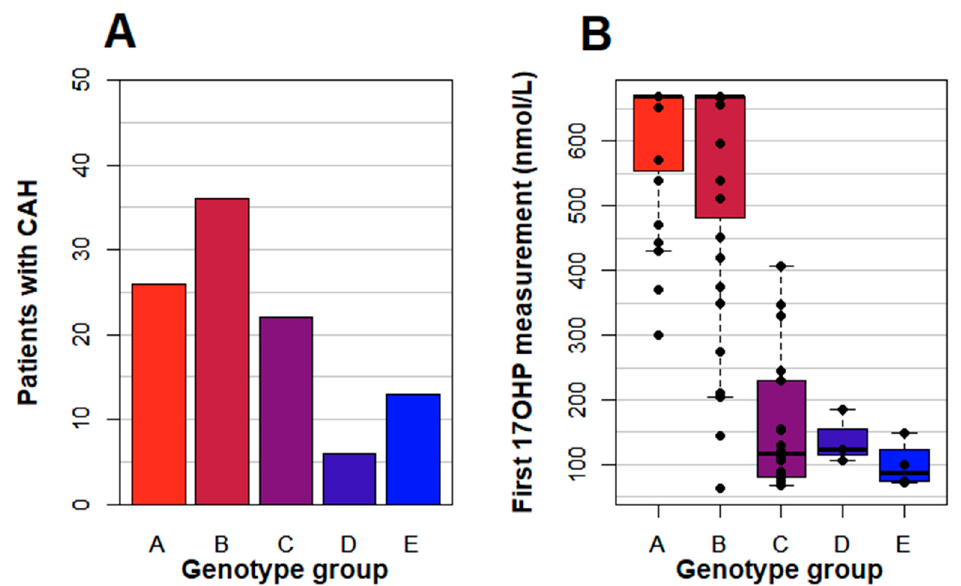
Figure 2. Distribution of all CAH patients’ CYP21A2 genotype groups ( n = 103) ( A ) and correlations of the 17OHP values in the neonatal screening samples to the CYP21A2 genotype groups ( B ). The 17OHP level is given up to 670 nmol / L by the laboratory, which means that higher levels are reported as > 670 nmol / L. Five patients are not included in graph B due to a missing genotype in one case, missing 17OHP in one case and sampling prior to 48 h in three cases.